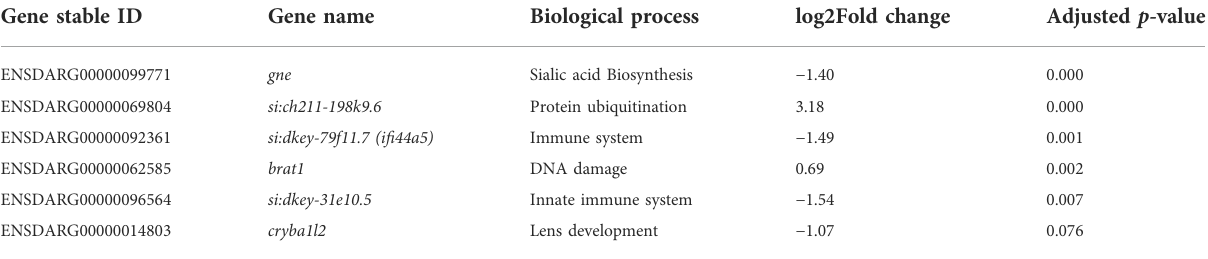
TABLE 1 Statistically Signi fi cant differentially expressed genes in gne KO versus gne WT zebra fi sh at 3 dpf. Gene stable ID